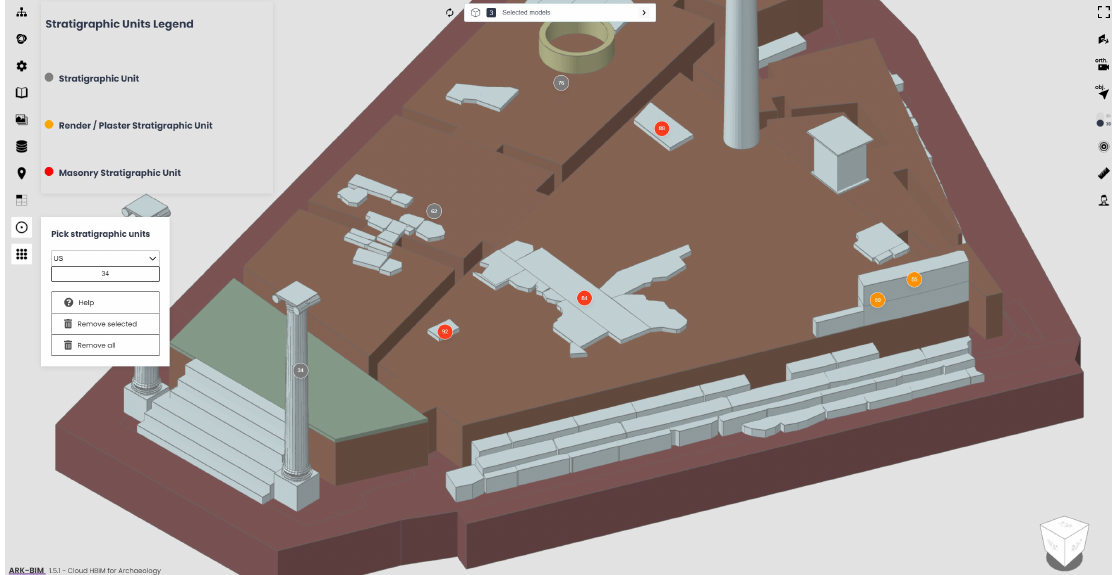
Figure 13. ARK-BIM (version 1.5.1): Pick Stratigraphic Units plugin. Sample archaeological stratigraphy picked directly from the sample model. Three classes of units available (US, USM, USR).